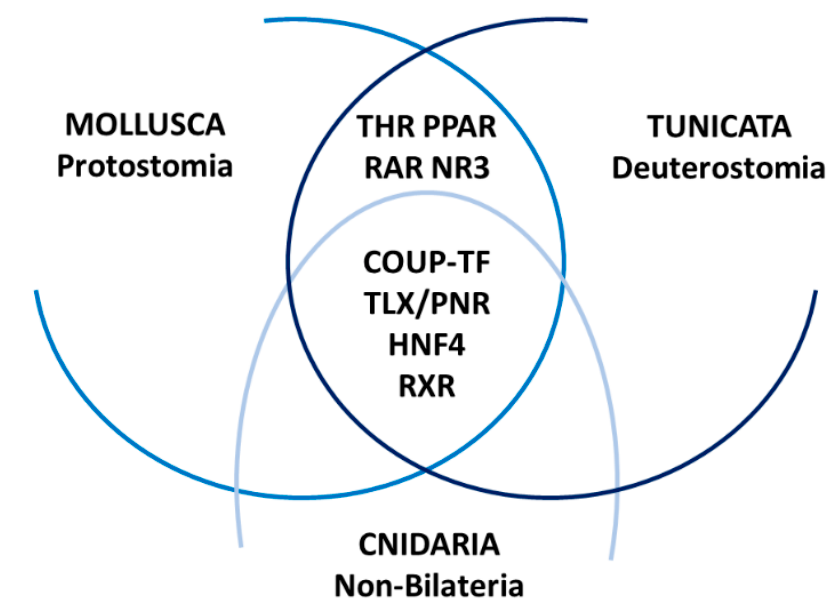
Figure 5. Ancestral sets of nuclear receptors (NRs) define the development of marine invertebrates. Members of the NR2 subfamily (COUP-TF, TLX/PNR, HNF4, RXR) are dynamically expressed during development of cnidarians, mollusks and tunicates. Albeit their presence in the genomes of at least medusozoan cnidarians, NR3 receptors only contribute to the developmental NR complements of the two bilaterian taxa, mollusks and tunicates. Members of the NR1 subfamily (THR, PPAR, RAR) are dynamically expressed during development of both protostomes and deuterostomes, further expanding the bilaterian set of NRs with developmental functions.